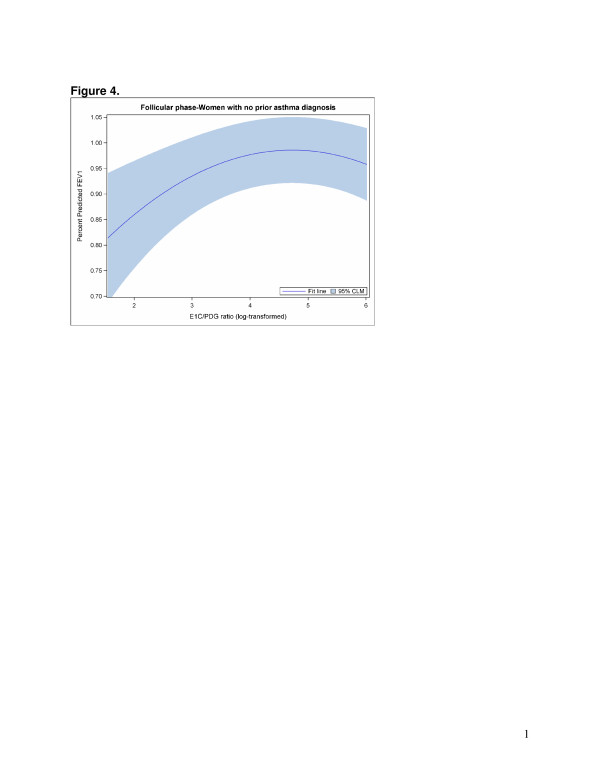
The log of E1C hormone level (x axis) associated with percent predicted FEV1 (y axis) in the follicular phase among women with no prior asthma diagnosis. For purposes of illustrating the relationship between log ratio and FEV1, menstrual segment day is held constant at 7 days prior to ovulation.